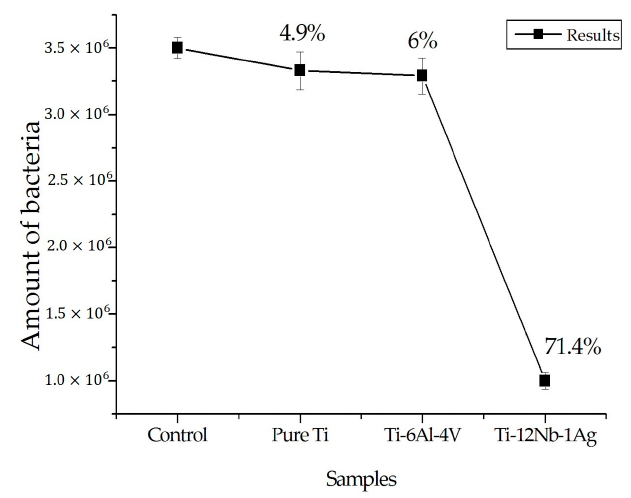
Figure 2. Comparison of E . coli antibacterial test results of pure Ti with Ti–6Al–4V and Ti–12Nb–1Ag alloys.